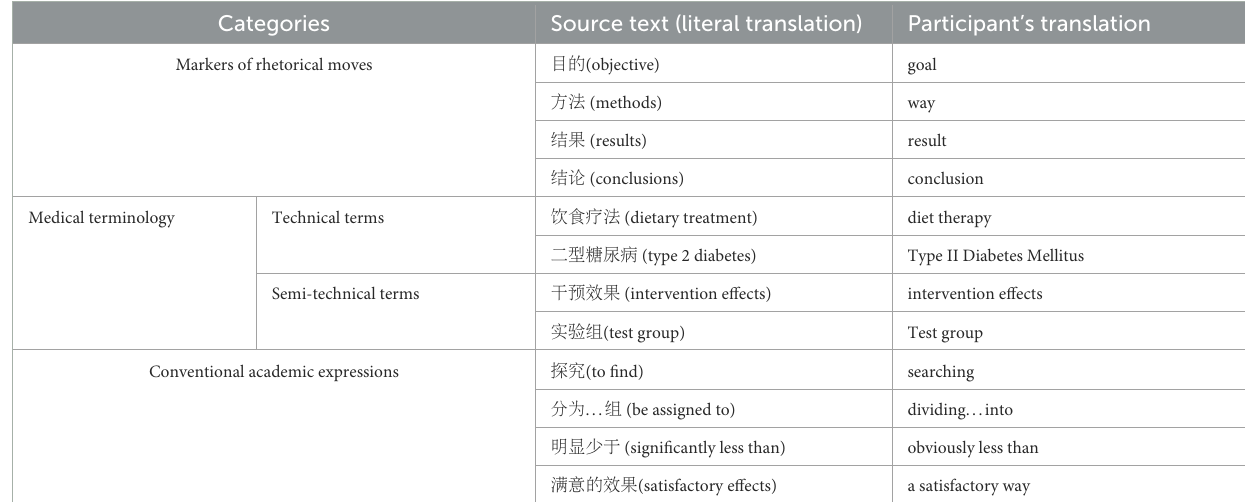
TABLE 1 Expressions the participant felt